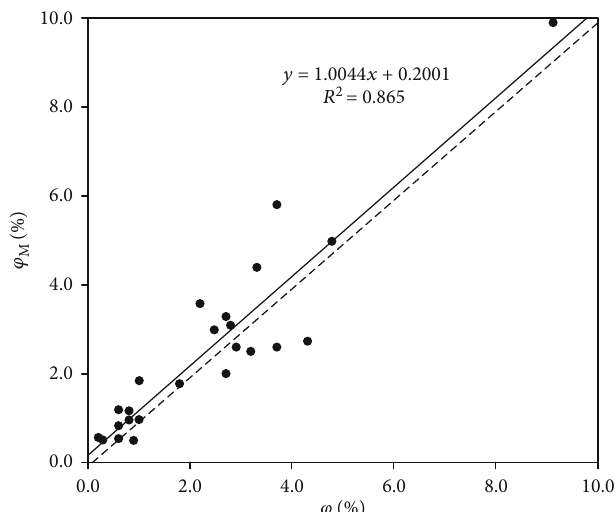
Figure 6: Comparison of total porosity values obtained from core plug helium porosimetry (horizontal axis) and porosity obtained from multifractal analysis on digital image. Table 3: Average value of physical properties and multifractal parameters corresponding to di ff erent types of dolomites.